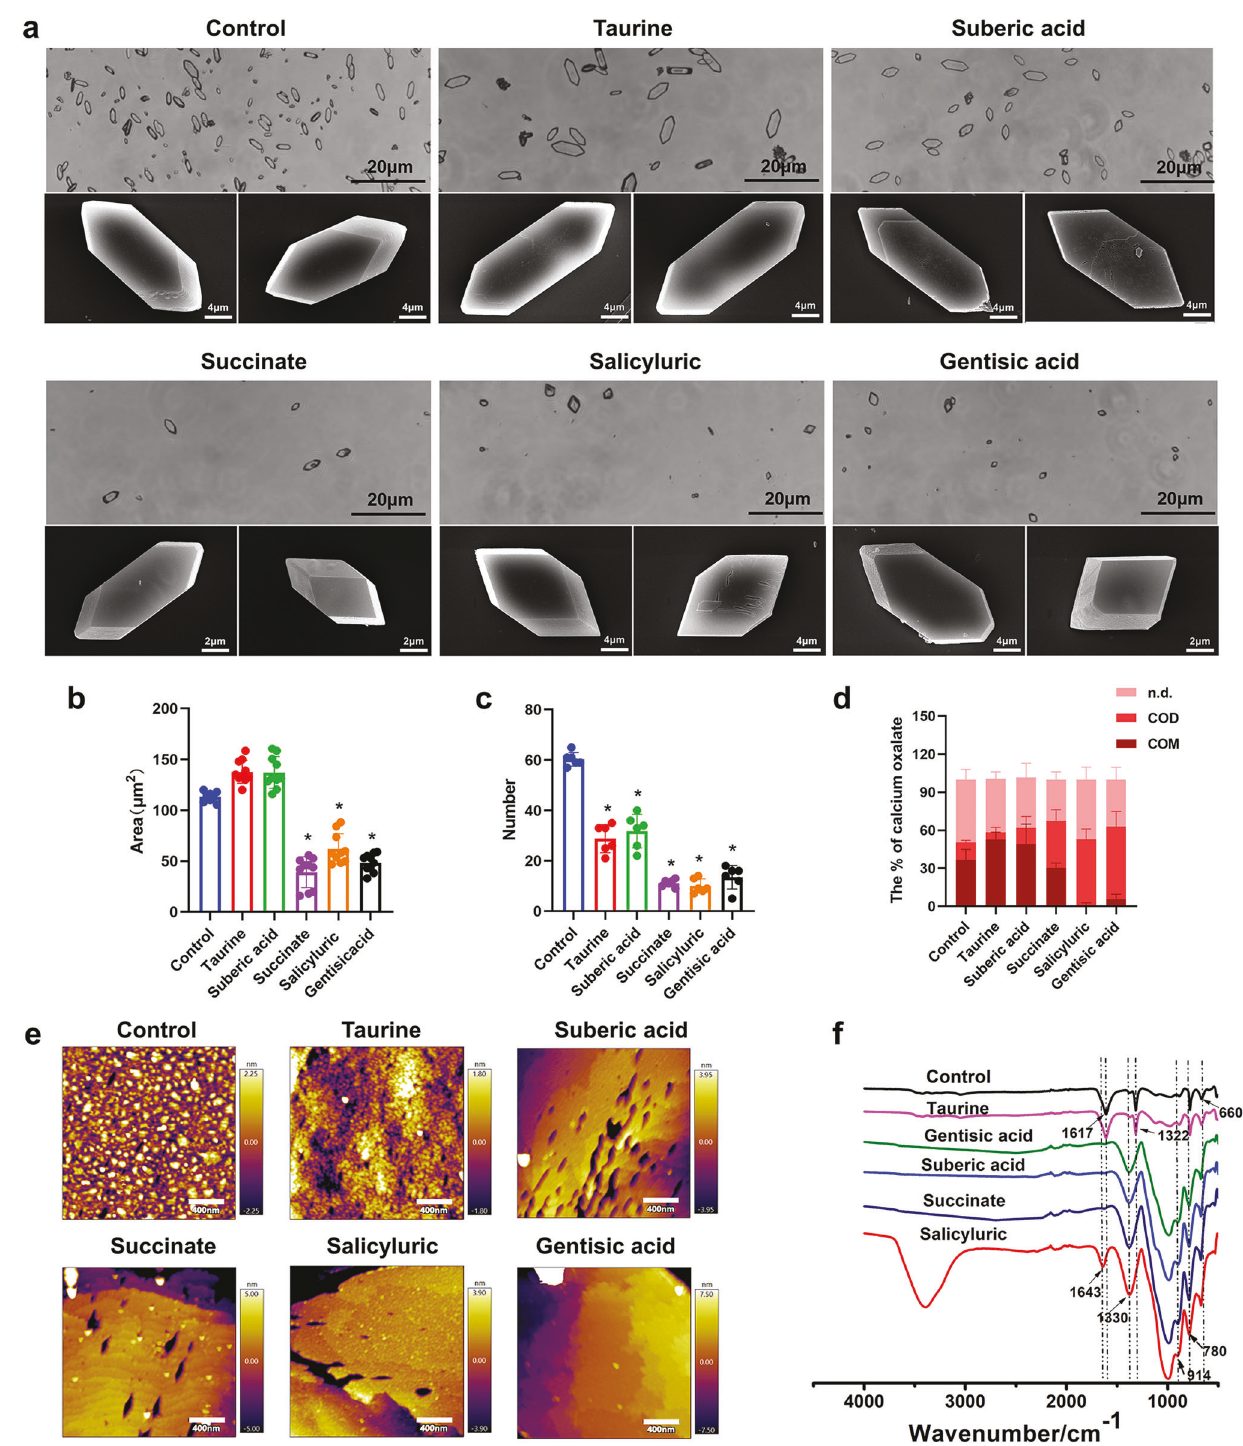
Fig. 4 Inhibition of COM nucleation in vitro. a Optical (scale bar: 20 μ m) and SEM (scale bar: 2 μ m & 4 μ m) micrographs. b – d Semi-quantitative analysis of the crystalized area and the number and ratio of COM and COD (COM — CaOx monohydrate, COD — CaOx dihydrate, n.d. — not de fi ned), * P < 0.05 compared with the control group. e AFM images of (001) surface growth and inhibition with or without the modi fi er (scale bar: 400 nm). f FTIR spectra with or without the modi fi er We have further assessed the in fl uence of modi fi ers on renal protection. While NaCl, salicyluric and gentisic acid treated EG- functions in various groups of rats. By Von Kossa staining (Fig. 5e, induced rat models have developed stones within 4 weeks, f, Supplementary Fig. 3), there were abundant crystal crystals in those treated with citric acid and succinate showed signi fi cant the border area between cortex and medulla in EG-treated rats. inhibition for stone formation, along with lower level of blood Compared with the citric acid, salicyluric and gentisic acid, CaOx BUN and plasma creatinine (Fig. 5d – h). Signal Transduction and Targeted Therapy (2023)